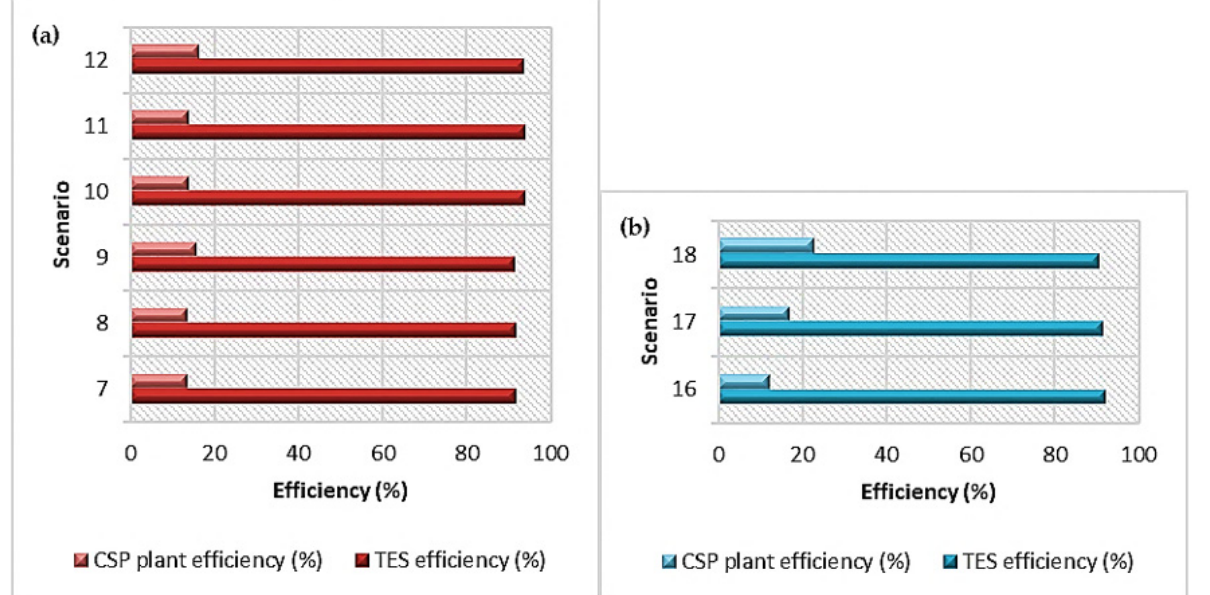
Figure 10. CSP plant efficiency and TES efficiency of 100 MW ( a ) PT power plants and ( b ) SPT power